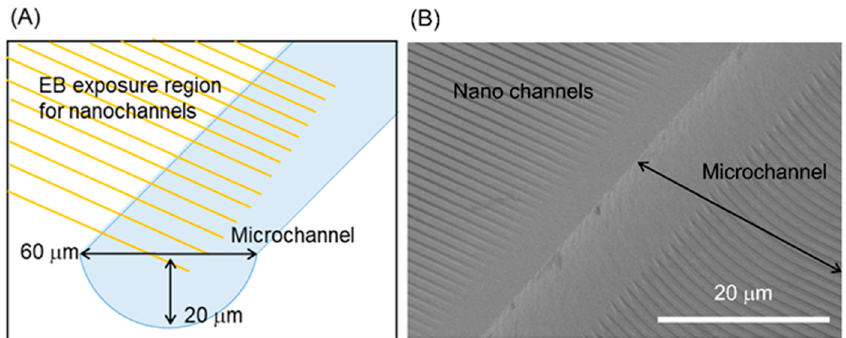
Figure 5. ( A ) Schematic illustration of the area over which nanochannels were fabricated on a substrate incorporating a microchannel. ( B ) SEM image of the resulting nanochannels.